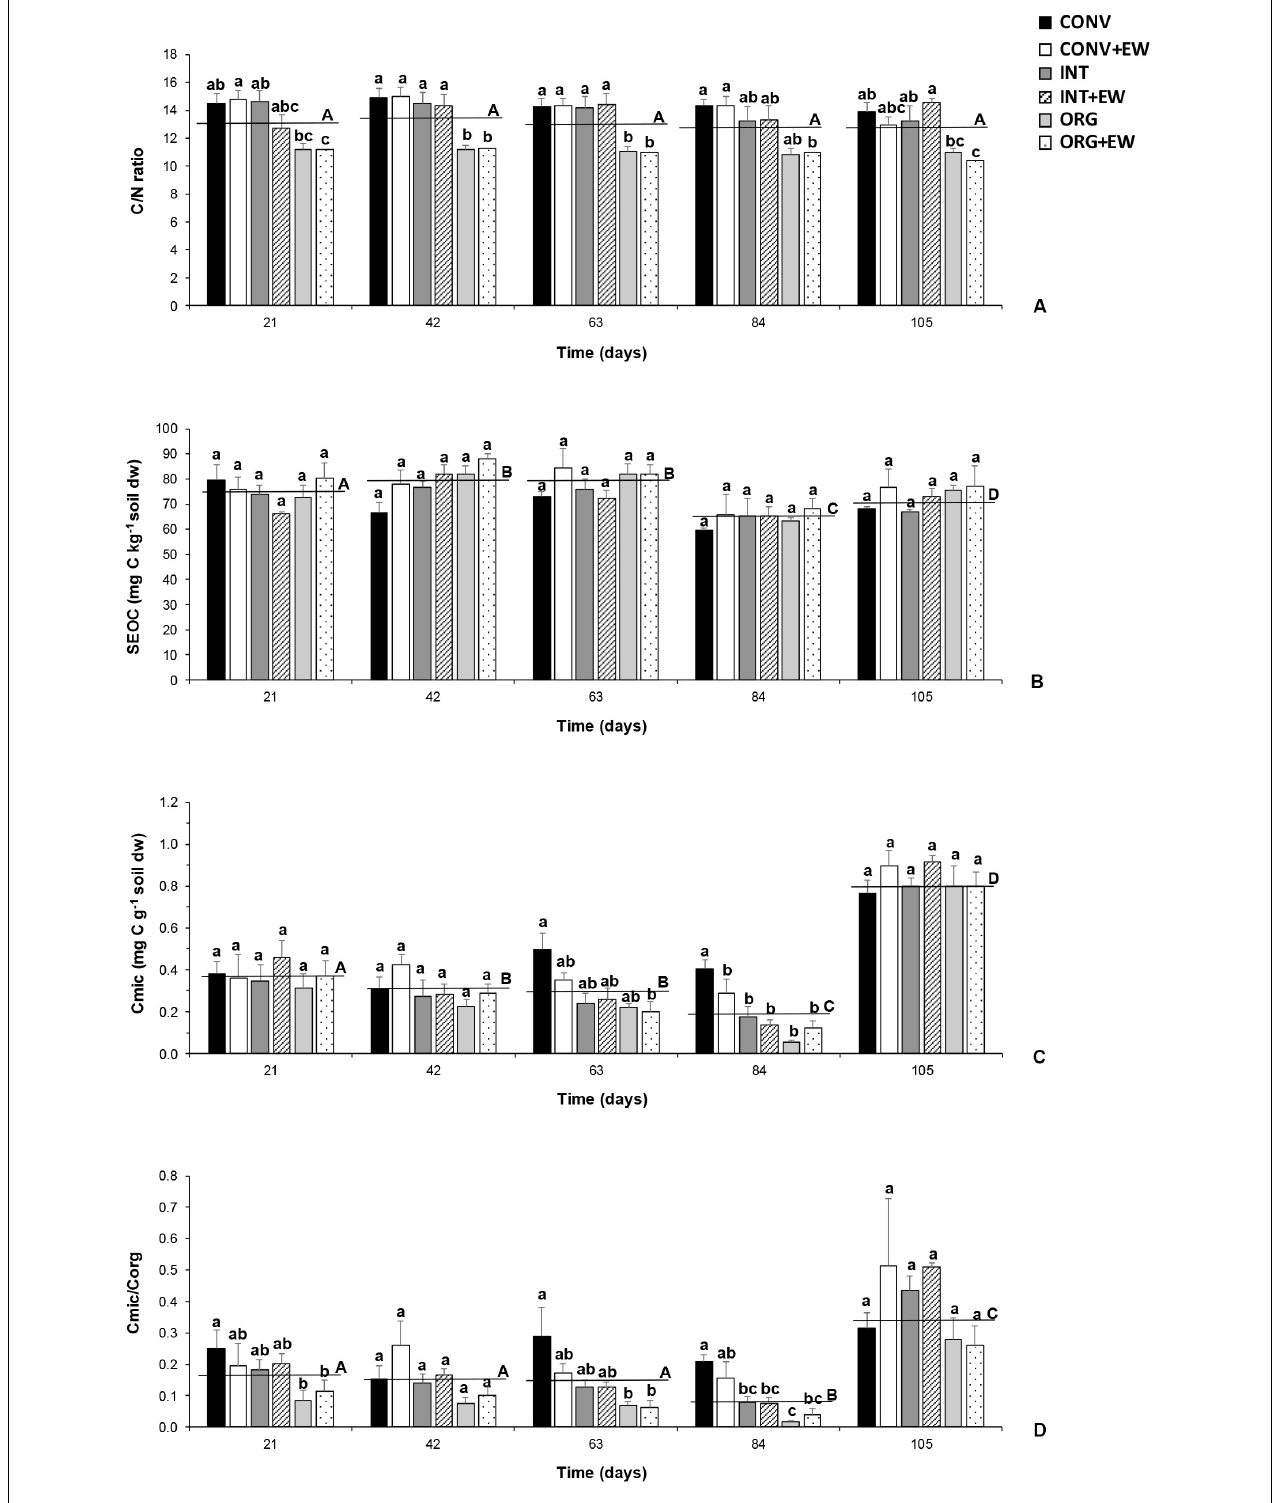
FIGURE 3 | Changes in the average values of C/N ratio (A) , SEOC (mg C kg − 1 soil dw) (B) , Cmic (mg C g − 1 soil dw) (C) and Cmic/Corg ratio (D) measured at each treatment (agricultural management and earthworm conditions combined) during the incubation period together with the averaged values per sampling time (horizontal lines). Different letters represent significant differences (repeated measures ANOVA) between treatments per sampling date (lower case) and between successive sampling times (upper case).